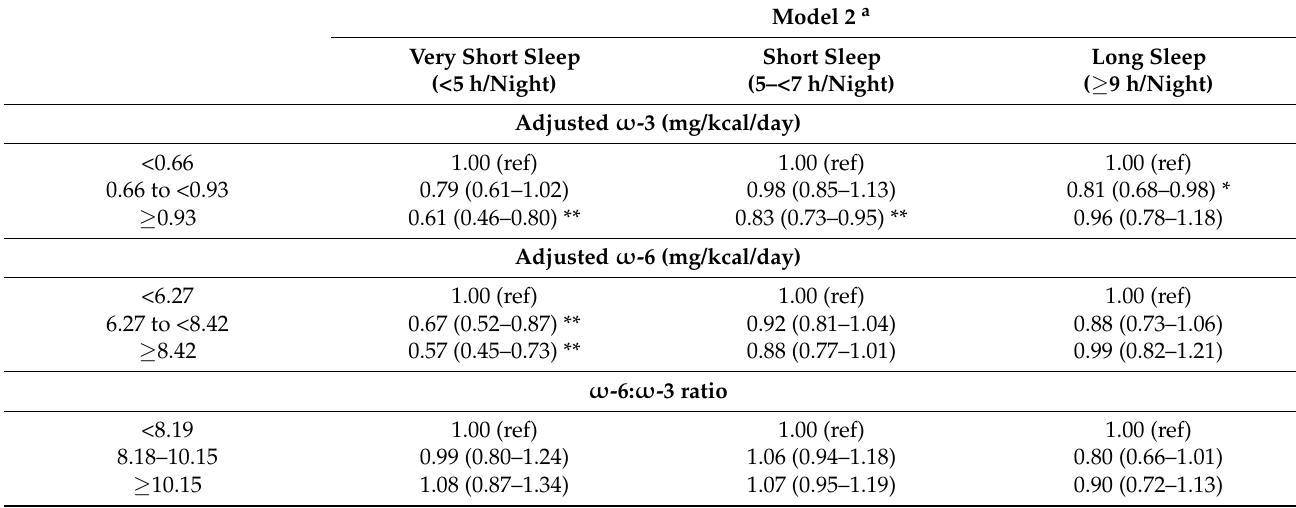
dietary ω -3 and ω -6 fatty acid intake and ω -6: ω -3 ratio, NHANES